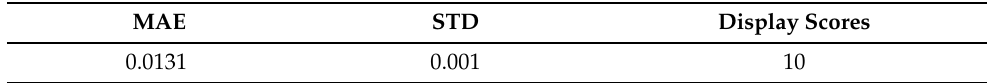
Table 4. Mean, standard deviation, and number for the Xgboost algorithm.